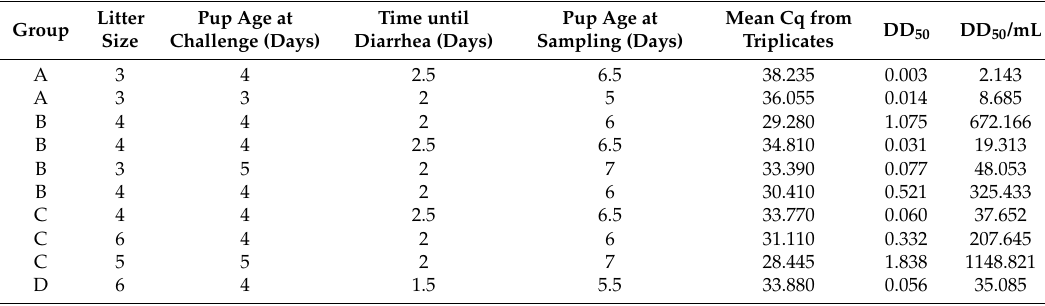
Table A11. This table summarizes the data and variables obtained during the challenge experiment shown in Figure